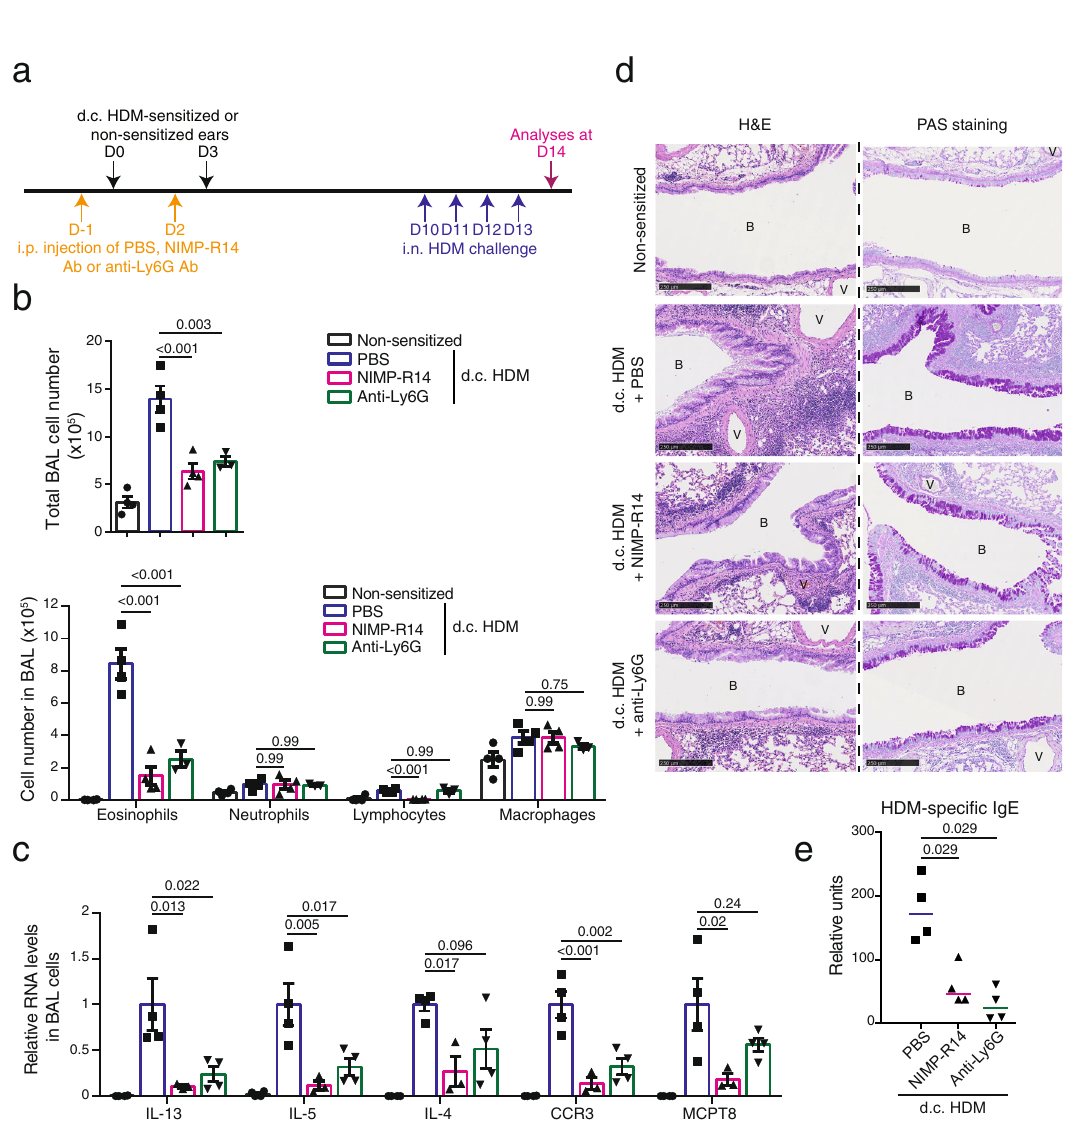
Fig. 6 | Depletion of IL-1 β -expressing cells during d.c. HDM sensitization reduces the subsequent asthmatic phenotype. a Experimental protocol. Wild- type Balb/c mice were intraperitoneally (i.p.) injected with PBS, NIMP-R14 or anti- Ly6G antibody (Ab) at day (D) -1 and D2. Mice were d.c. sensitized with HDM on LMP_91 μ m ears at D0 and D3 or non-sensitized. All mice were intranasally (i.n.) challengedwithHDMfromD10toD13andanalysedatD14. b Totalcellnumberand differential cellcounting inBAL fl uid ( n =4,4,4, 3mice). c Relative mRNA levelsof